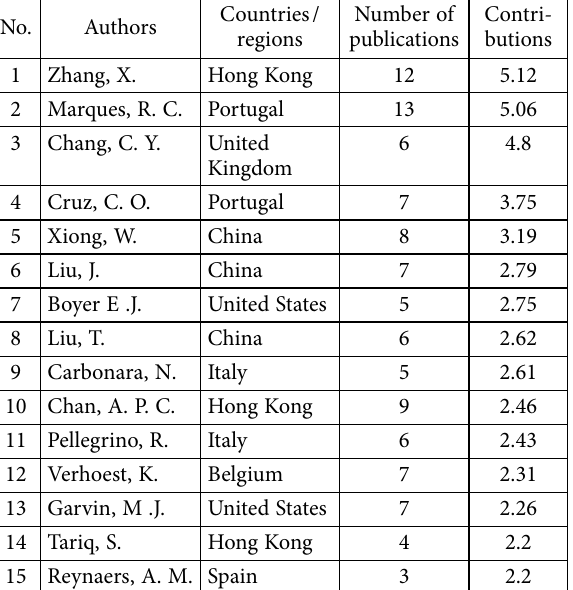
Table 3. Top 15 authors by contributions